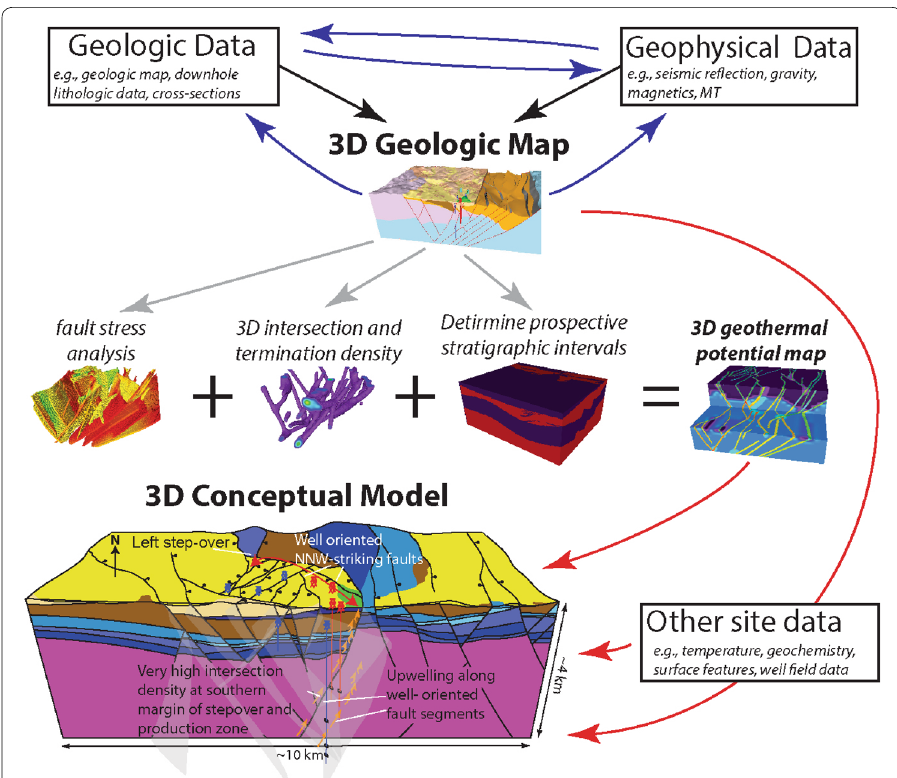
Fig. 3 Conceptual sketch illustrating the 3D geologic mapping and 3D geothermal potential mapping work flow. Geologic and geophysical data are integrated (black arrows) into a detailed 3D geologic map (“Methods: 3D geologic mapping”). Iteration of the interpretation between geologic and geophysical data, as well as between early versions of the 3D map and input data (blue arrows) is required to ensure that the 3D geologic map is consistent with all input data. The 3D geologic map is used to evaluate geothermal potential in 3D (“Methods: geothermal potential mapping”). 3D fault and stratigraphic surfaces are used to conduct fault stress analysis (“Fault stress state”), calculate the density of fault intersections and fault terminations (“Fault intersections and terminations”), and determine prospective stratigraphic intervals (“Host rock lithology”), gray arrows. These three maps are summed to produce the 3D geothermal potential map (“Evaluating geothermal potential in 3D”). To elucidate the specific highly prospective areas of the 3D geothermal potential map, geologic information from the 3D geologic map, and additional information about known areas of fluid flow from temperature or other data are integrated (red arrows) to build the 3D conceptual model of geothermal processes (“Results and